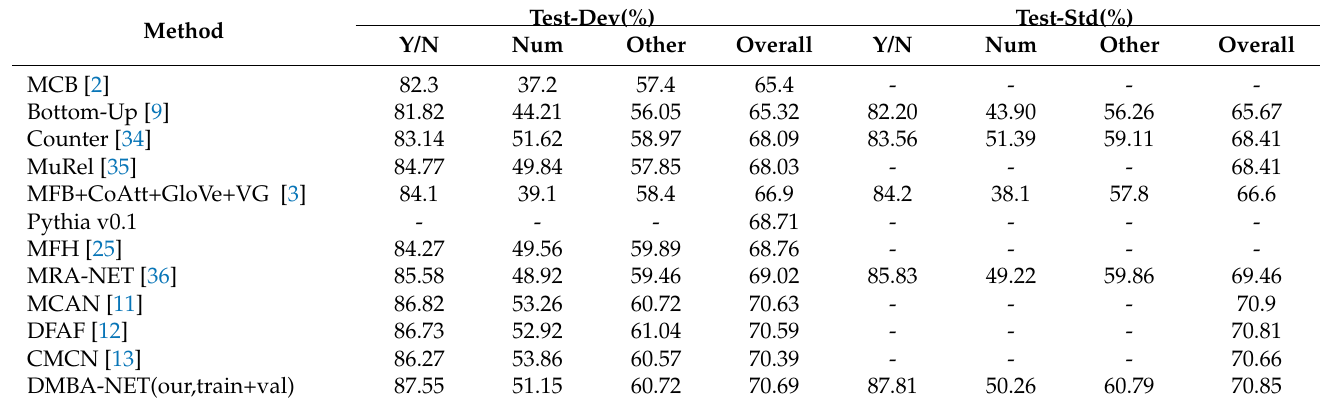
Table 5. Comparison with the state-of-the-art approaches on test-dev and test-std of VQA